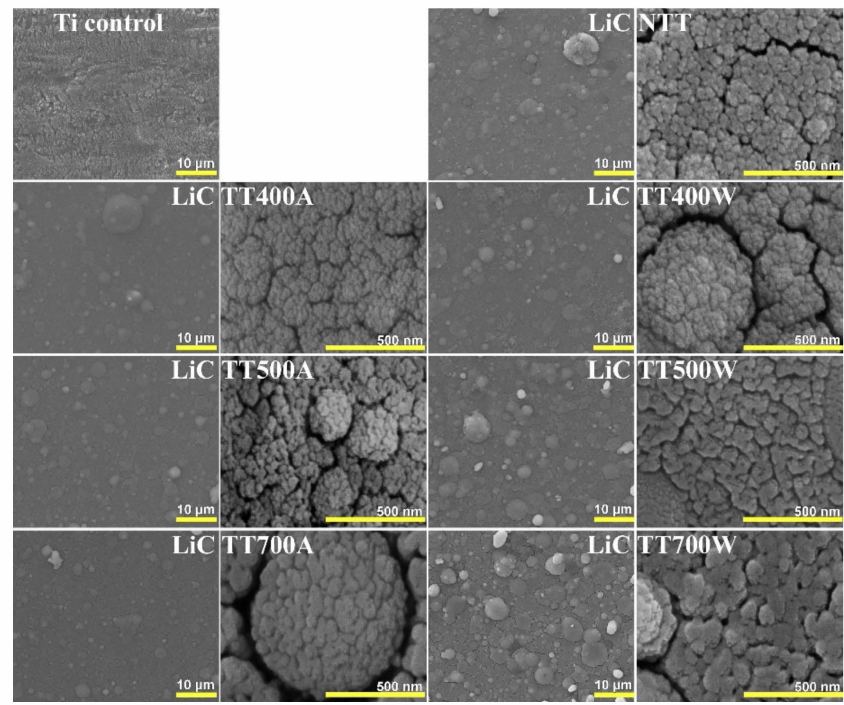
Figure 4. Top-view general and detailed SEM micrographs of control Ti, NTT LiC samples and of those subjected to post-deposition thermal treatments (at different temperatures), in air and water-vapor ambient, synthesized onto Ti substrates.